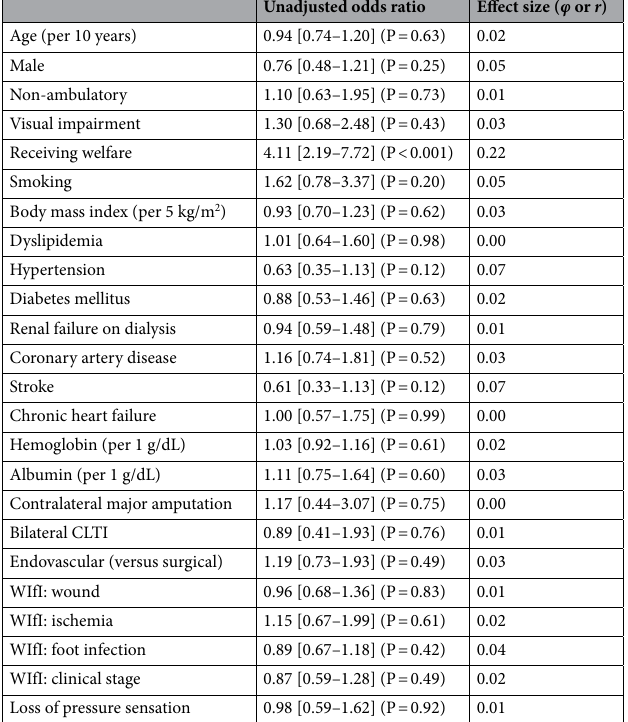
Table 2. Crude association between clinical characteristics and living alone in the overall study population ( n = 413). Odds ratios, derived from the logistic regression model, are presented together with 95% confidence intervals. CLTI chronic limb-threatening ischemia, WIfI wound, ischemia, and foot